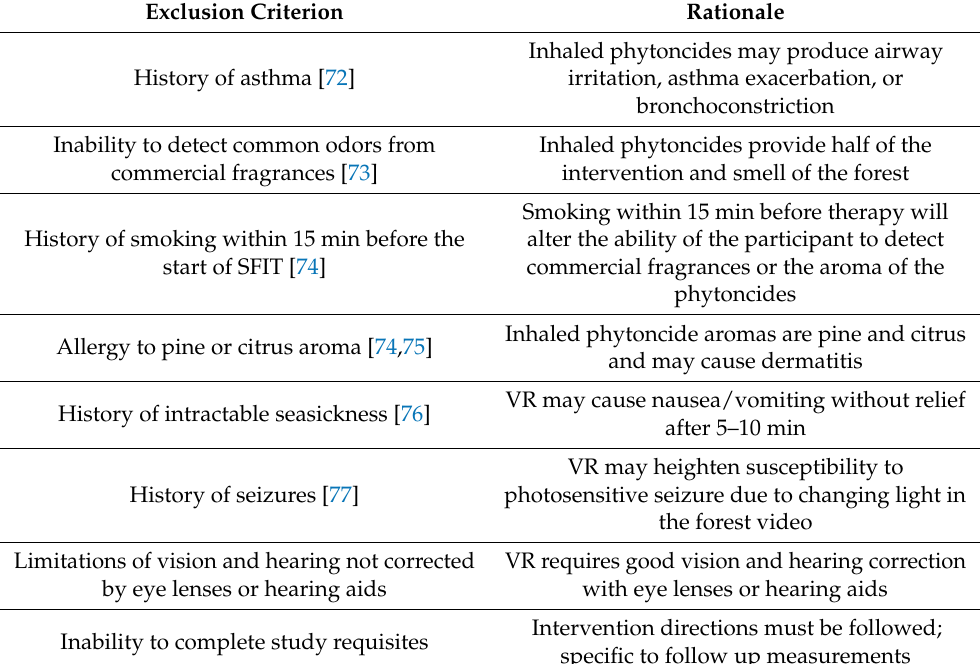
Table 1. General exclusion criteria related to intervention